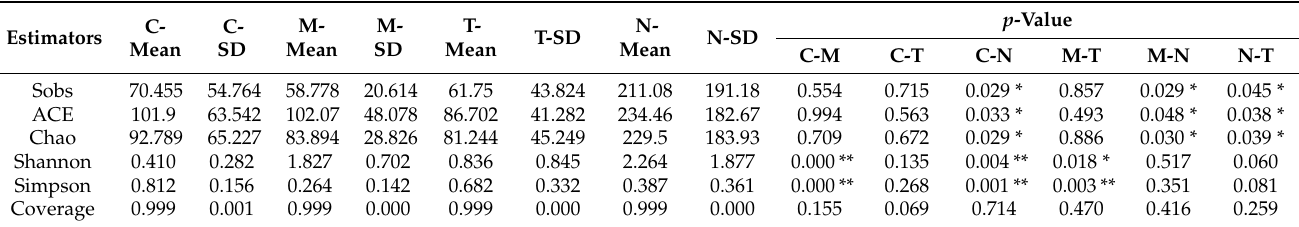
Table 3. Analysis of alpha diversity